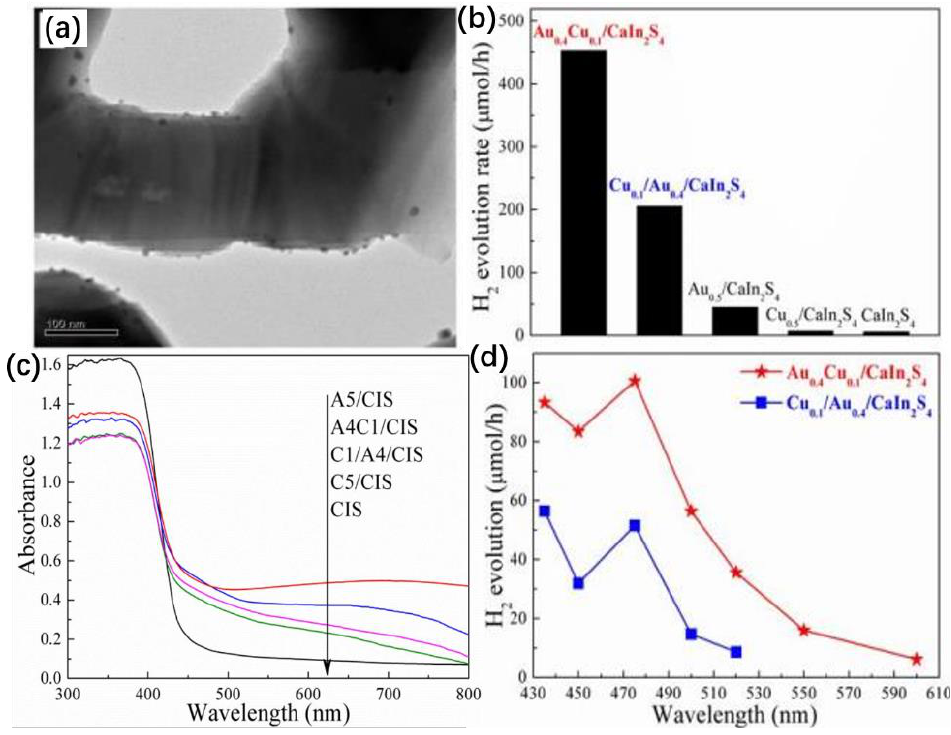
Figure 3. ( a ) TEM image of Au 0.4 Cu 0.1 /CaIn 2 S 4 composite. ( b ) Hydrogen production rate of Au 0.5 − xCu x /CaIn 2 S 4 (A 0.5 − xCx/CIS) composites with different contents of Cu. ( c ) UV – vis absorption spectra of Au 0.5 /CaIn2S4(A5/CIS), Au 0.4 Cu 0.1 /CaIn2S4(A4C1/CIS), Cu 0.1 /Au 0.4 /CaIn 2 S 4 (C1/A4/CIS), Cu 0.5 /CaIn 2 S 4 (C5/CIS), and CaIn 2 S 4 (CIS). ( d ) Photocatalytic hydrogen production rate over Au 0.4 Cu 0.1 /CaIn 2 S 4 and Au 0.4 Cu 0.1 /CaIn 2 S 4 composites as functions of the incident light wavelength.